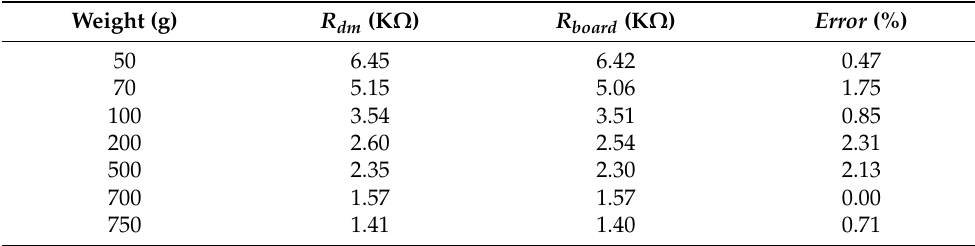
Figure 10. ( a ) Test setup with the readout board, “ FSR-406 ”, and weights; ( b ) comparison of the “ FSR-406 ” responses using a digital multimeter and the readout board. Table 4. Results of the readout board with “ FSR-406 ” for the weight range of 50 – 750 g.